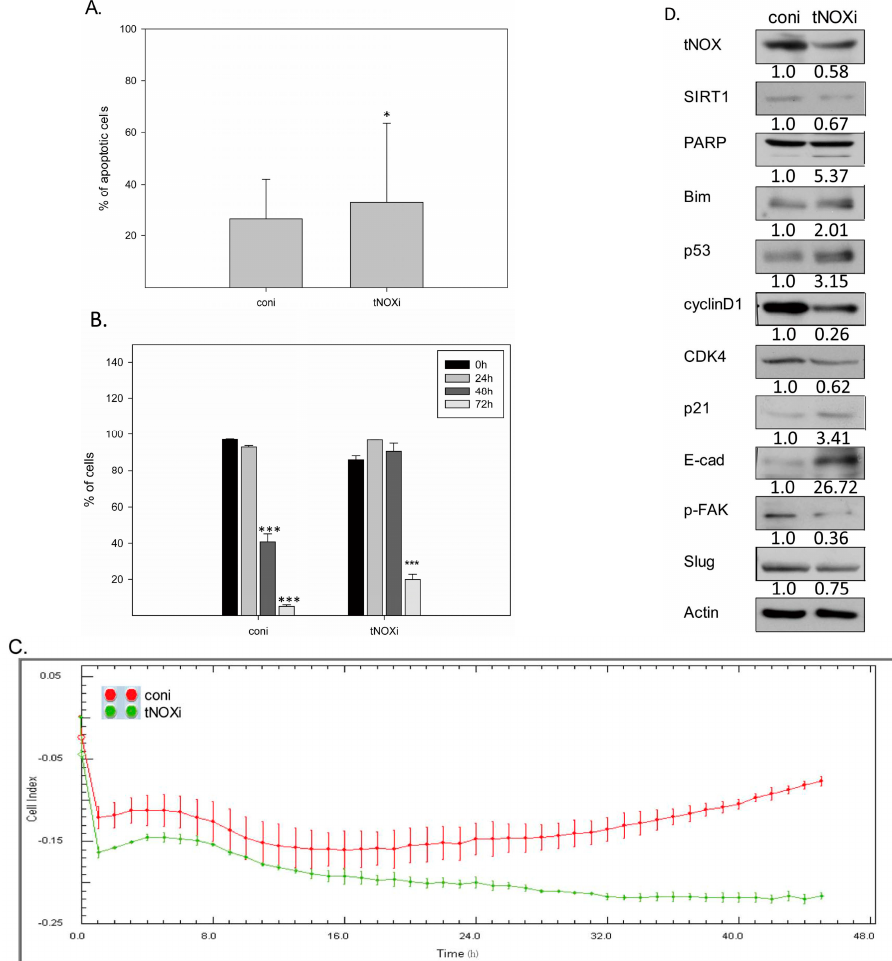
Figure 5. The siRNA-mediated knockdown of tNOX suppresses multiple cancer phenotypes. tNOX was down-regulated by siRNA, and cells were assayed for various cellular functions. ( A ) The percentage of apoptotic cells was determined by flow-cytometry, and the results are expressed as a percentage of apoptotic cells. Values (mean ˘ SE) are from three independent experiments by t -test (* p < 0.05); ( B ) Cell division was analyzed by CMFDA staining of tNOX-knockdown and control cells. The presented values (mean ˘ SE) represent at least three independent experiments by one-way ANOVA with LSD (* p < 0.05); ( C ) Dynamic monitoring of cell migration using impedance technology, as described in Materials and Methods. Shown are normalized cell index measured over 45 h; ( D ) Aliquots of cell lysates were separated by SDS-PAGE and analyzed by western blotting; β -actin was used as an internal control. Representative images from three experiments are